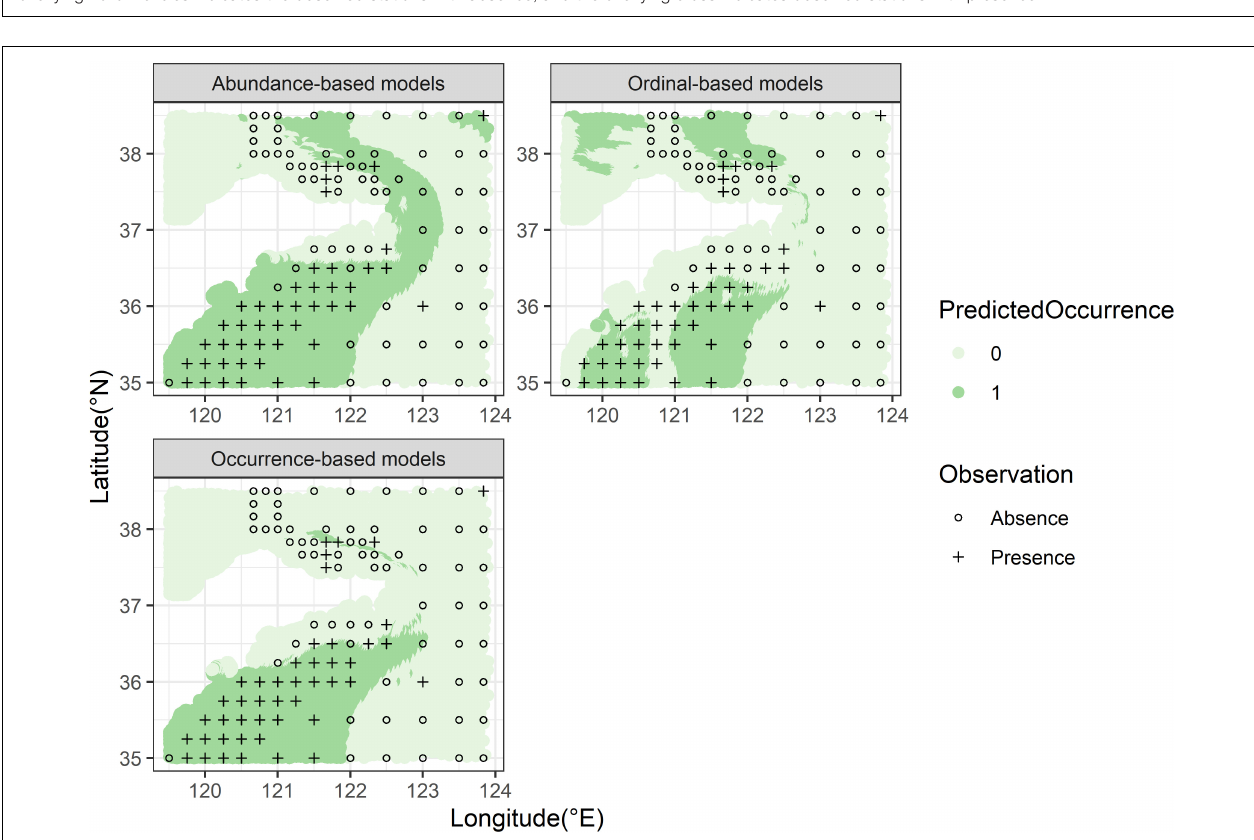
FIGURE 6 | The predicted (color circles) distribution ranges of M. dalei by RF for uses of three species data types in the coastal waters of Shandong Peninsula. The overlying hollow circles indicates the observed stations with absence, and the overlying cross indicates observed stations with presence.